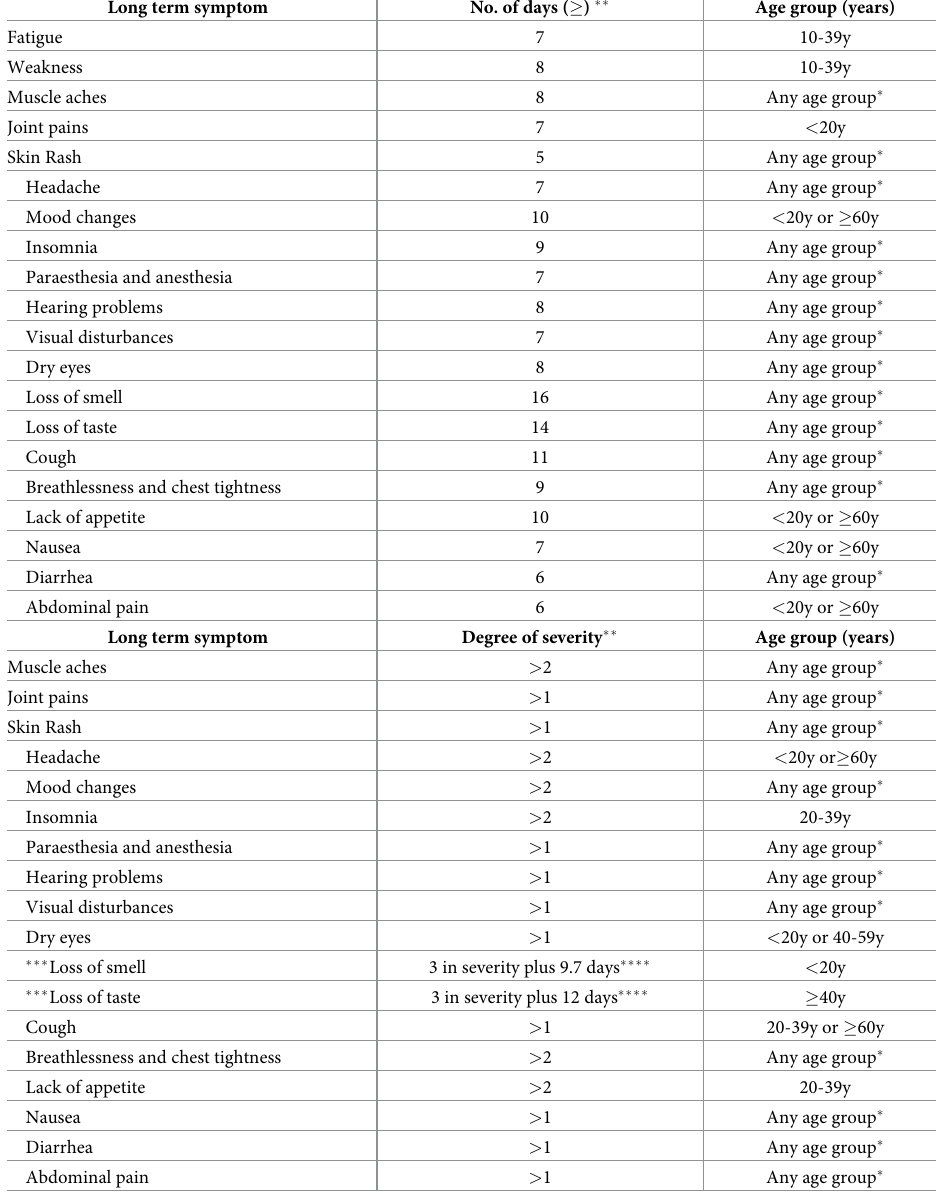
Table 5. (Level 2 A): Scoring Post-recovery COVID-19 long term symptoms persistence (Lower concerns groups) . Scoring method: One point given for each item per symptom (one point for days and one point for age group). Interpretation: Score two for any symptom: follow up is recommended for the patient for each symptom got score 2. (Level 2 B): Scoring Post-recovery COVID-19 long term symptoms degree of severity (Lower concerns groups) . Scoring method: One point given for each item per symptom (one point for degree of severity and one point for age group) with exception for loss of smell and loss of taste. Interpretation: Score two for any symptom: follow up is recommended for the patient for each symptom got score